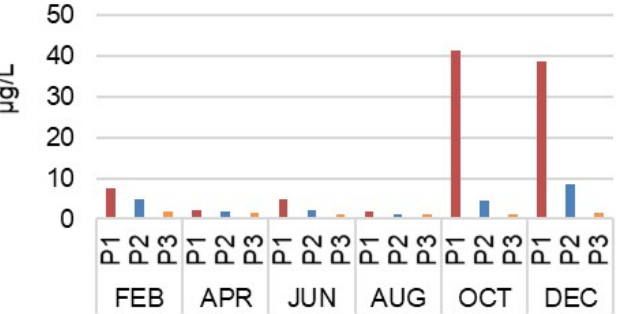
Figure 4. Nutrients in the Piranji Estuary (equatorial Southwestern Atlantic, Brazil, 2015). Point upstream of the river (P1) to the point closest to the estuarine mouth